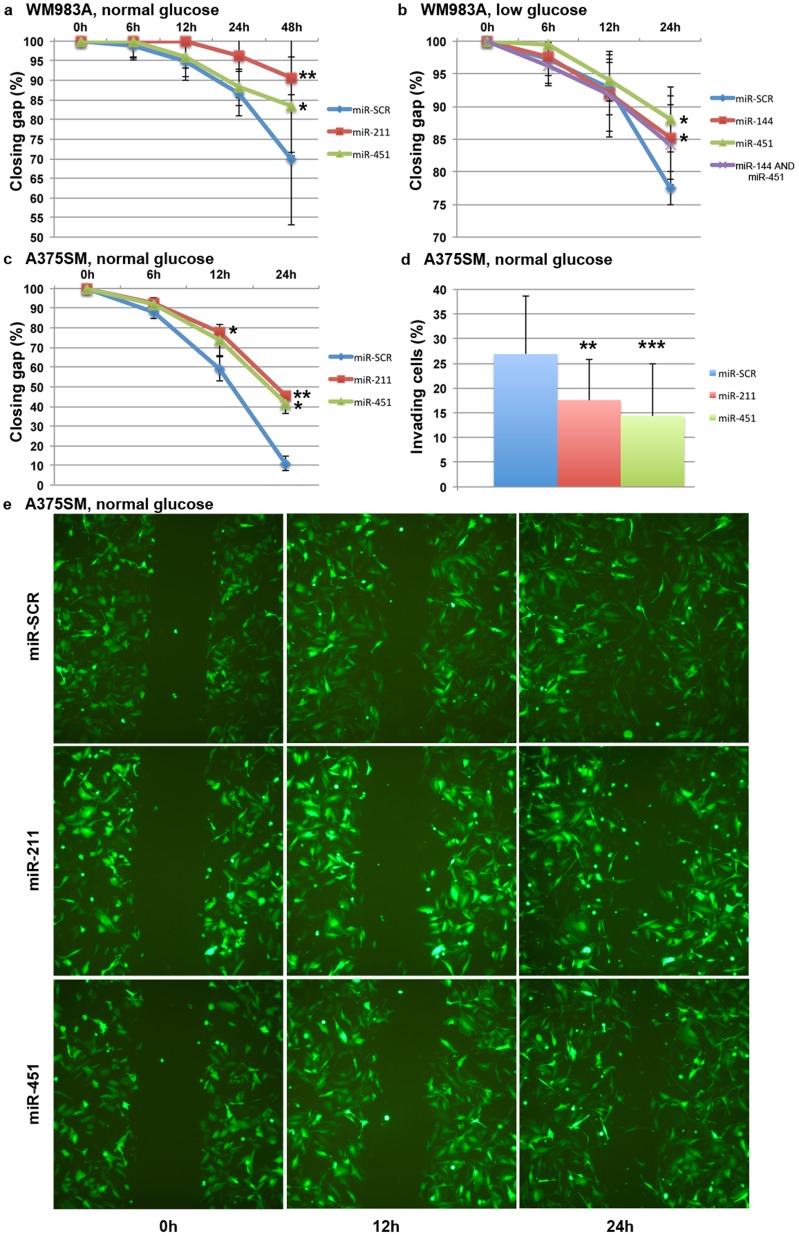
Expressing either miR-211 or miR-451a retarded migration and invasion of melanoma cells.(a) miR-211 or miR-451a significantly reduced the migration rate of WM983A cells after 48 h in normal glucose (4.5 g/L). (b) Lowering glucose (0.3 g/L) dramatically retarded migration rate of miR-451a or miR-144-transfected WM983A cells after 24 h; expressing both miR-144 and miR-451a together did not result in an added effect of retarded migration. (c) Moreover, expressing either miR-211 or miR-451a reduced the migration rate and (d) invasion of A375SM cells, respectively. (e) Cells transfected with miR-SCR nearly closed the gap by cross migration after 24 h whereas this process was retarded by miR-211 and miR-451a. The error bars represent standard deviation from at least two different independent experiments. *P-value<0.05; **P-value<0.005; ***P-value<0.0005.